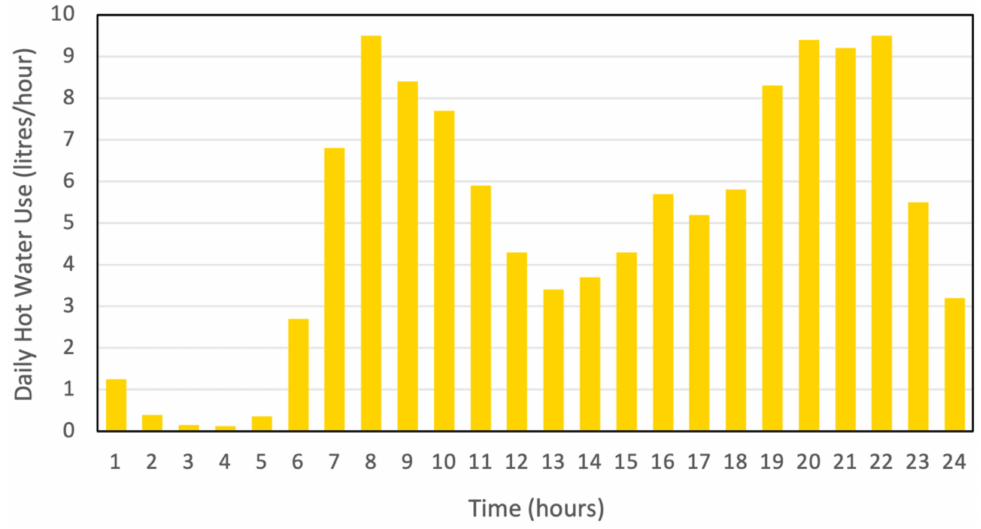
Figure 1. Hourly hot water use profile.